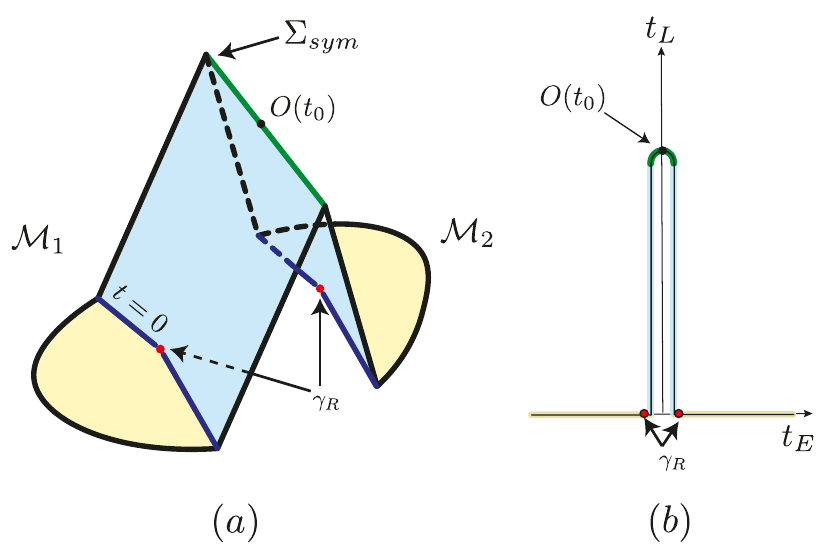
Figure 3 . (a) The saddle point for h ψ | Π R (0) O ( t 0 )Π R (0) | ψ i has two conical defects (red) at γ R on the bra and ket side respectively. It has a Z 2 symmetry that leaves invariant the Cauchy slice Σ sym (green). This slice splits the saddle into two parts M 1 and M 2 . The region of the saddle point shaded light blue can be thought of as the spacetime inherent to the fixed-area state, while the yellow portion is involved in the preparation of the state. We may take the blue portion to lie at real Lorentzian times and the yellow portion to lie at real Euclidean times. In that sense, the two blue portions each involve the same interval of real Lorentzian times and should perhaps be drawn as being degenerate with each other, but we have separated the pieces for ease of visualization. (b) The corresponding Schwinger-Keldysh contour in the complex-time